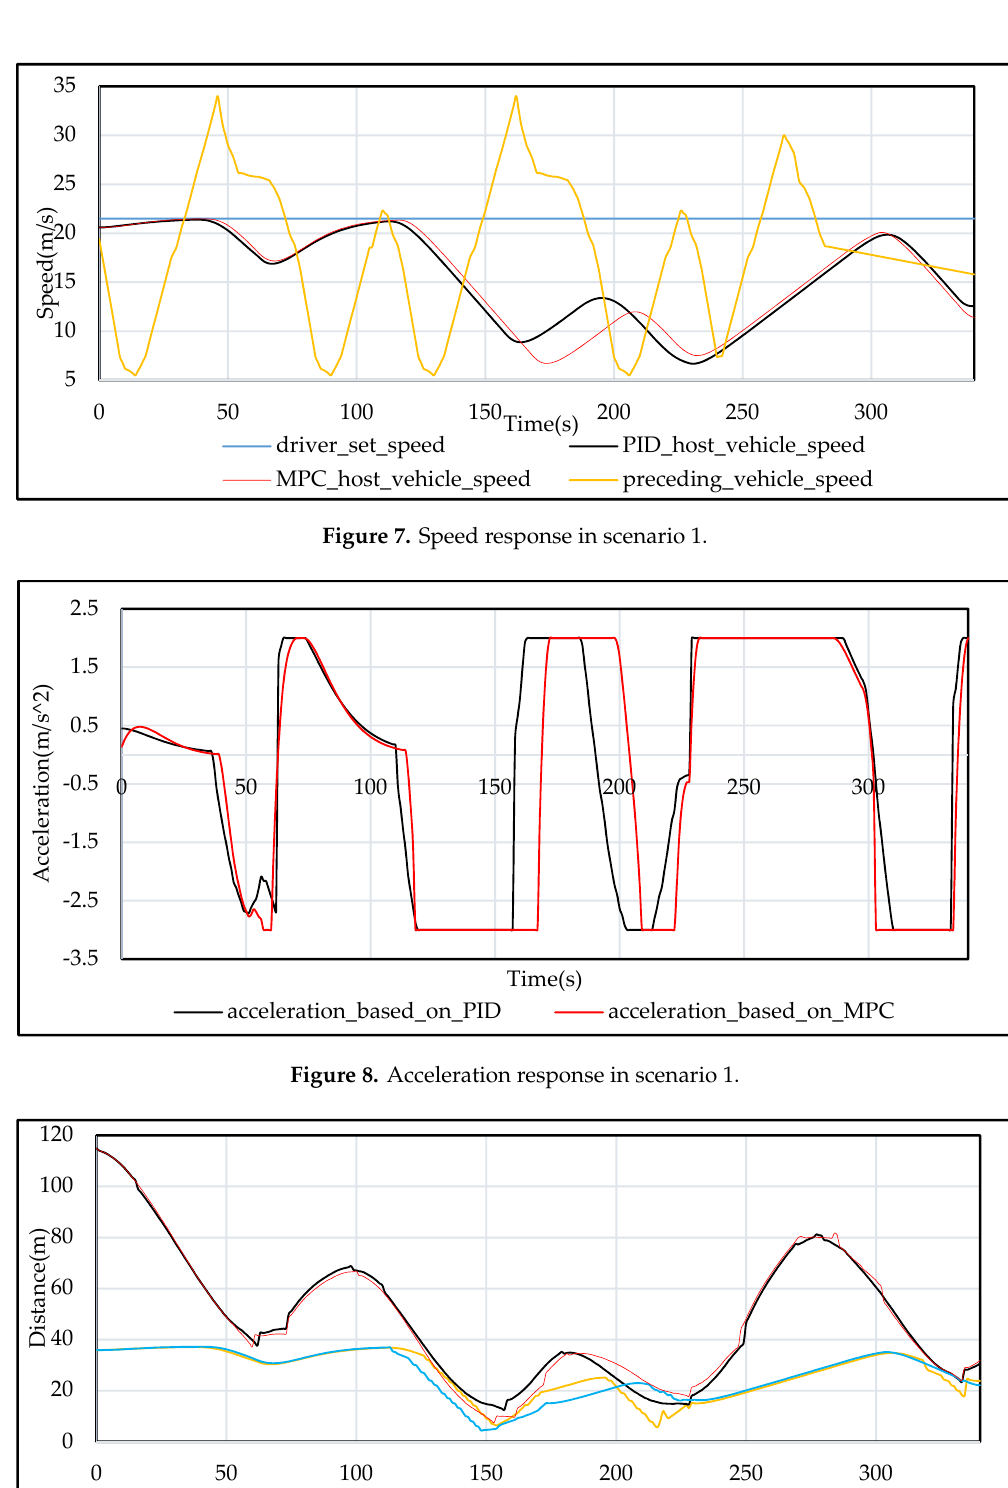
Figure 10. Fuel economy in scenario 1. In scenario 2, which is about following the changing preceding vehicles with cut in and cut out behaviors, the ACC-equipped host vehicle operates along a predefined road section. At the outset, the host green vehicle follows a preceding red vehicle. Then, a yellow vehicle traveling on the neighboring lane cuts into the lane of the host vehicle, and becomes the newly preceding vehicle. After a period, this newly preceding yellow vehicle changes to another lane so that the original red one becomes the preceding vehicle again. The scenario concept is demonstrated in Figure 11. The proposed ACC system is required to make the reaction to the change in the preceding vehicle on the road. The initial velocity of the host vehicle is assumed to be 20.5 m/s . The simulation results of two control algorithms, ACC based on classic PID controller and ACC based on the proposed MPC controller, are shown in Figure 12–15, and the results for the emissions are reported in Table 3.